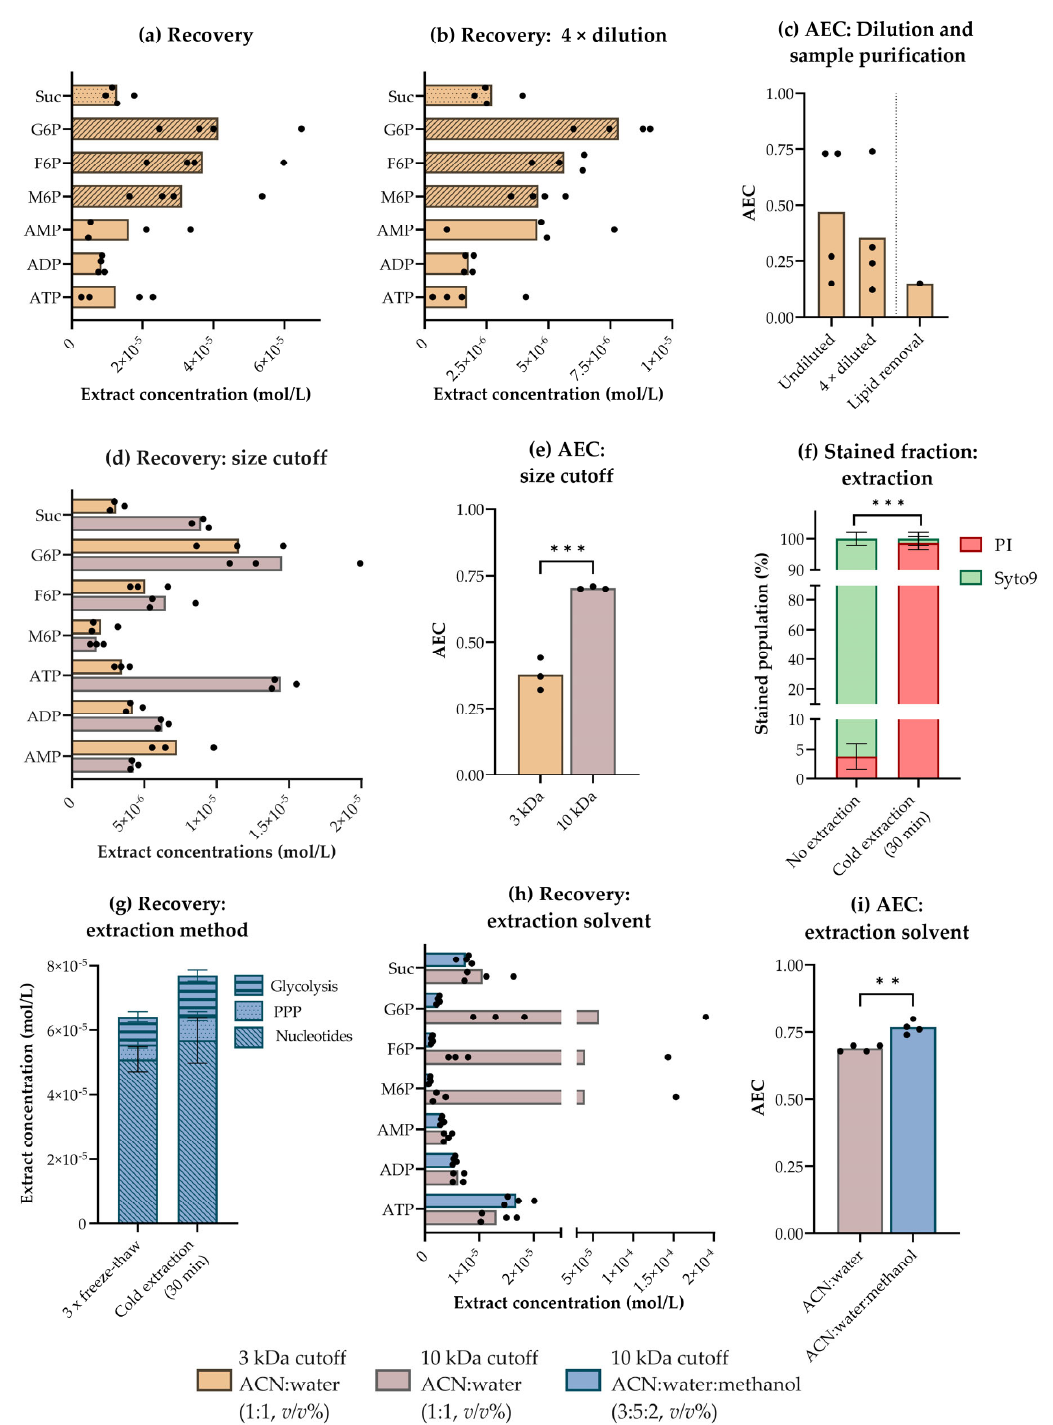
Figure 5. Recovery and stability in E. coli metabolite extracts subjected to different extraction and sample purification procedures. Extract concentrations (mol/L) of selected intermediates of central carbon metabolism in ( a ) undiluted and ( b ) four ‐ times diluted acetonitrile (ACN):water (1:1, v/v %) E. coli extracts cleared by size ‐ exclusion centrifugation with a cutoff of 3 kDa. ( c ) Adenylate energy charges (AECs) in undiluted and four ‐ times diluted E. coli extracts (left panel) and in E. coli extracts